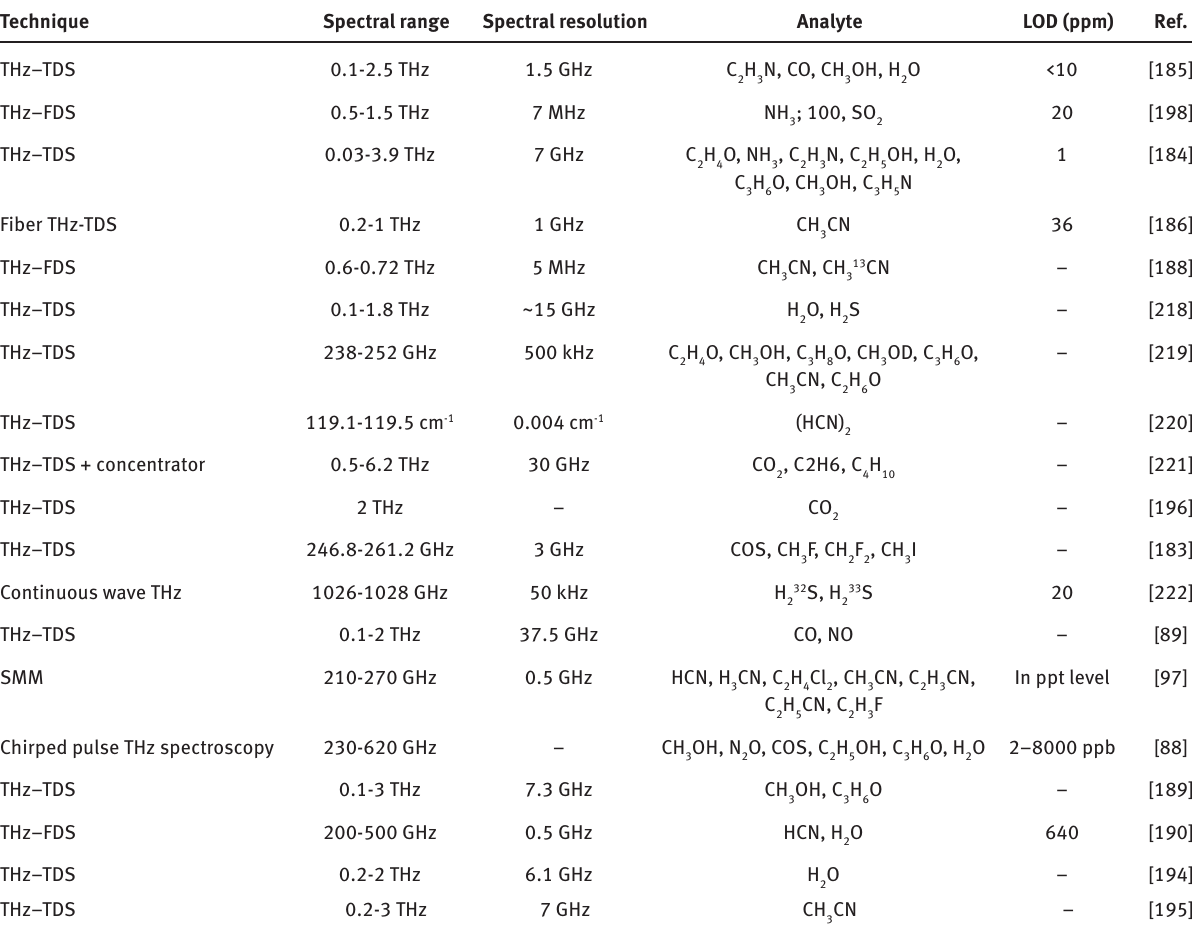
Table 2: Sensing parameters of schemes and devices based on THz spectroscopy for the detection of